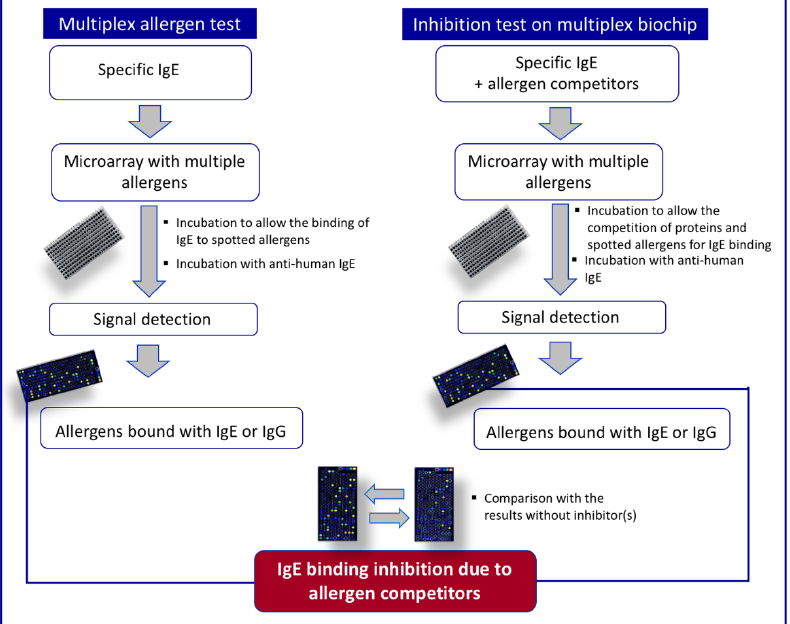
Figure 1. Schematic representation of a multiplex immunoassay, generally used for allergy diagnosis, in comparison with the inhibition assay on a multiplex biochip, such as the single point highest inhibition achievable assay (SPHIAa).